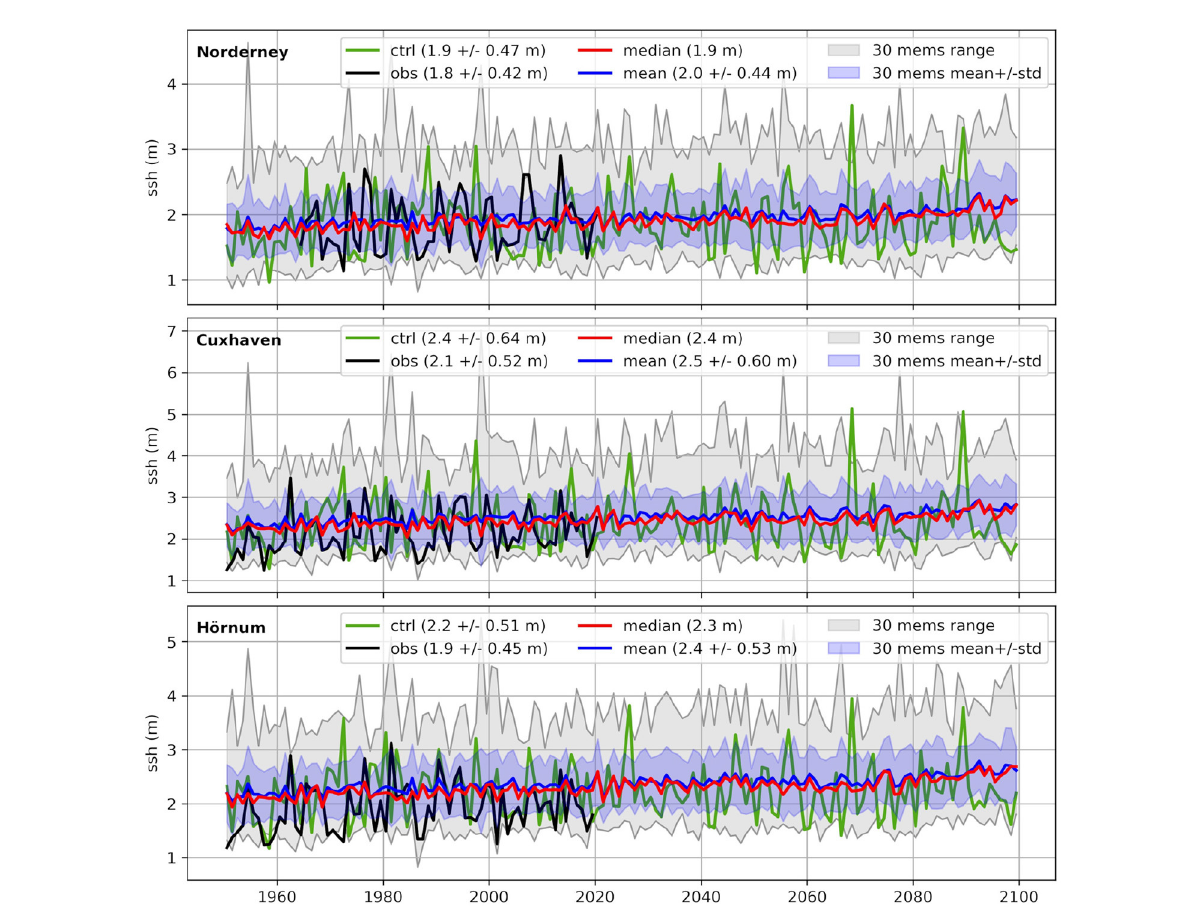
FIGURE3 Extreme SSH in terms of yearly maxima above MWH (1970–1999) of the transient ensemble simulations (gray shading), ensemble mean (blue) ± ensemble standard deviation (blue shading), ensemble median (red), observed data (black), and PI control simulation (green) at Norderney, Cuxhaven, and Hörnum. For this graph, time series were not detrended. Numbers in legend: overall mean ± standard deviation, for ensemble mean: mean ± mean of standard deviation. Source of observed data: Wasserstraßen- und Schifffahrtsamt Elbe-Nordsee, location Tönning,